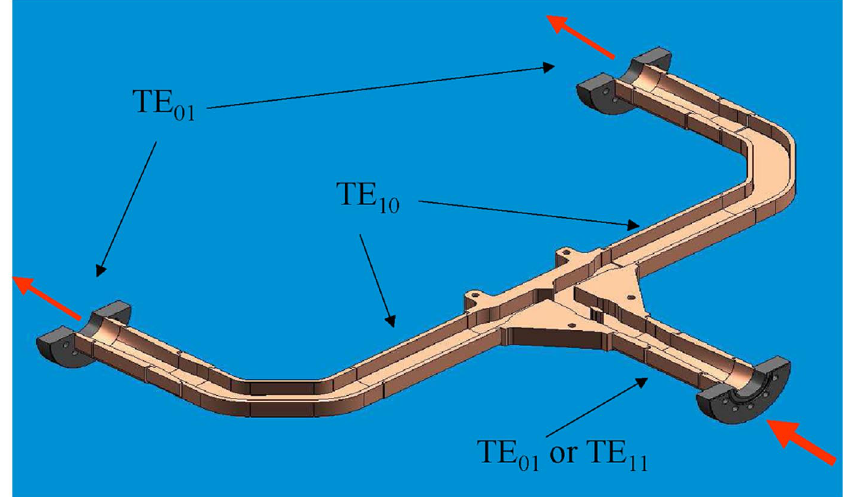
FIG. 12. (Color) Dual-mode splitter. Irrespective of the incident mode, the power is split between two outputs, each of which launches mode. the TE 01